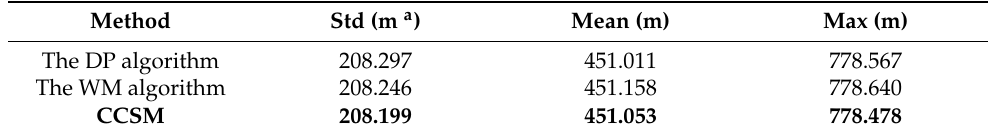
Table 3. Numerical evaluation of the positional errors between the initial and simplified contours obtained by the DP algorithm, WM algorithm, and CCSM at the same scale.